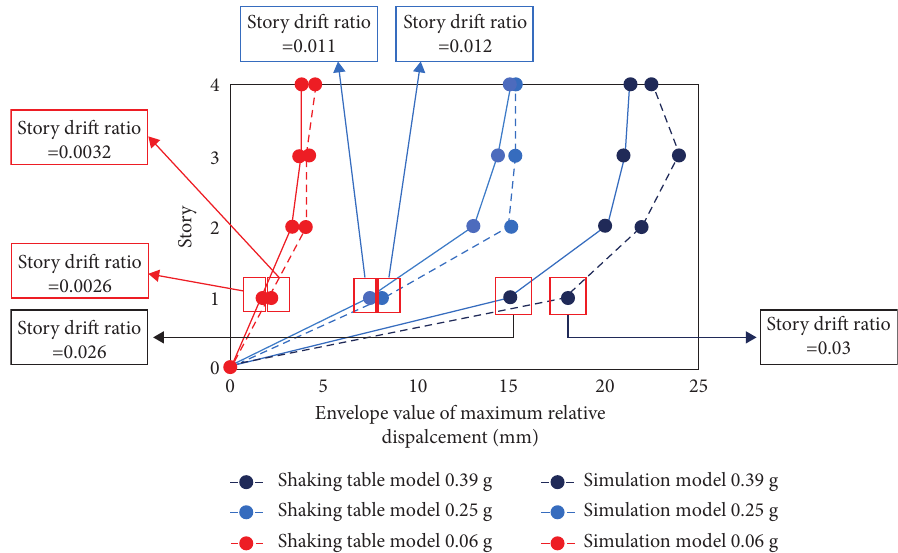
Figure 44: Envelope value of maximum relative displacement of simulation and shaking table model.